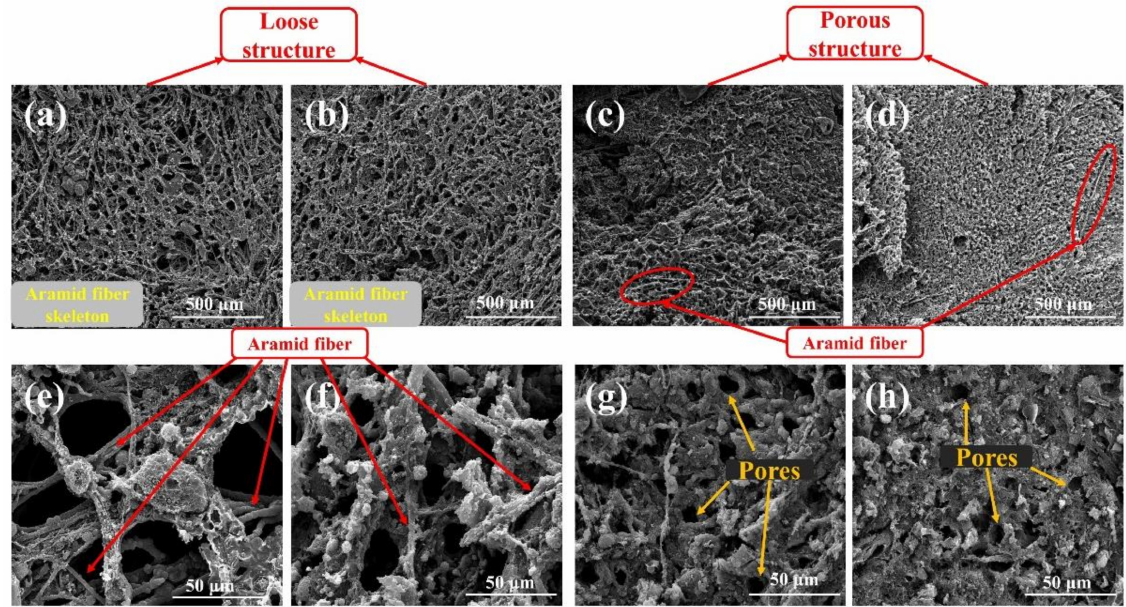
Figure 2. Effects of MWCNTs content on char layer surface of EPDM-based insulators without silica: NS-C-0 (400 × ( a ), 3000 × ( e )), NS-C-0.3 (400 × ( b ), 3000 × ( f )), NS-C-3 (400 × ( c ), 3000 × ( g )) and NS-C-6 (400 × ( d ), 3000 × ( h )).